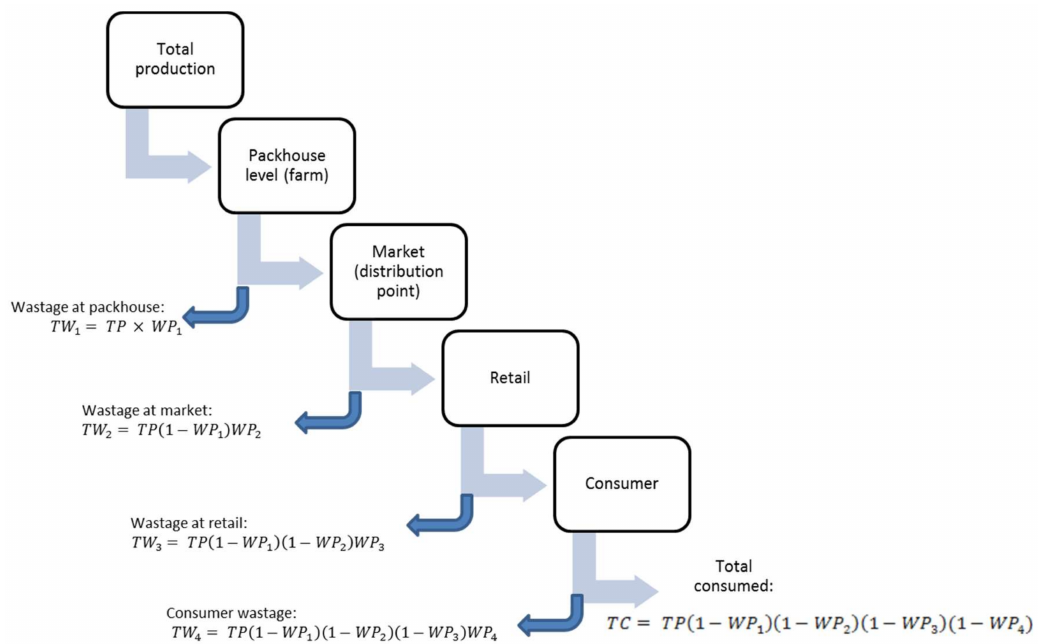
Figure 1. Calculating wastage for the stages along the supply chain of vegetables (carrots, cabbage, beetroot, broccoli and lettuce) from the farmer to